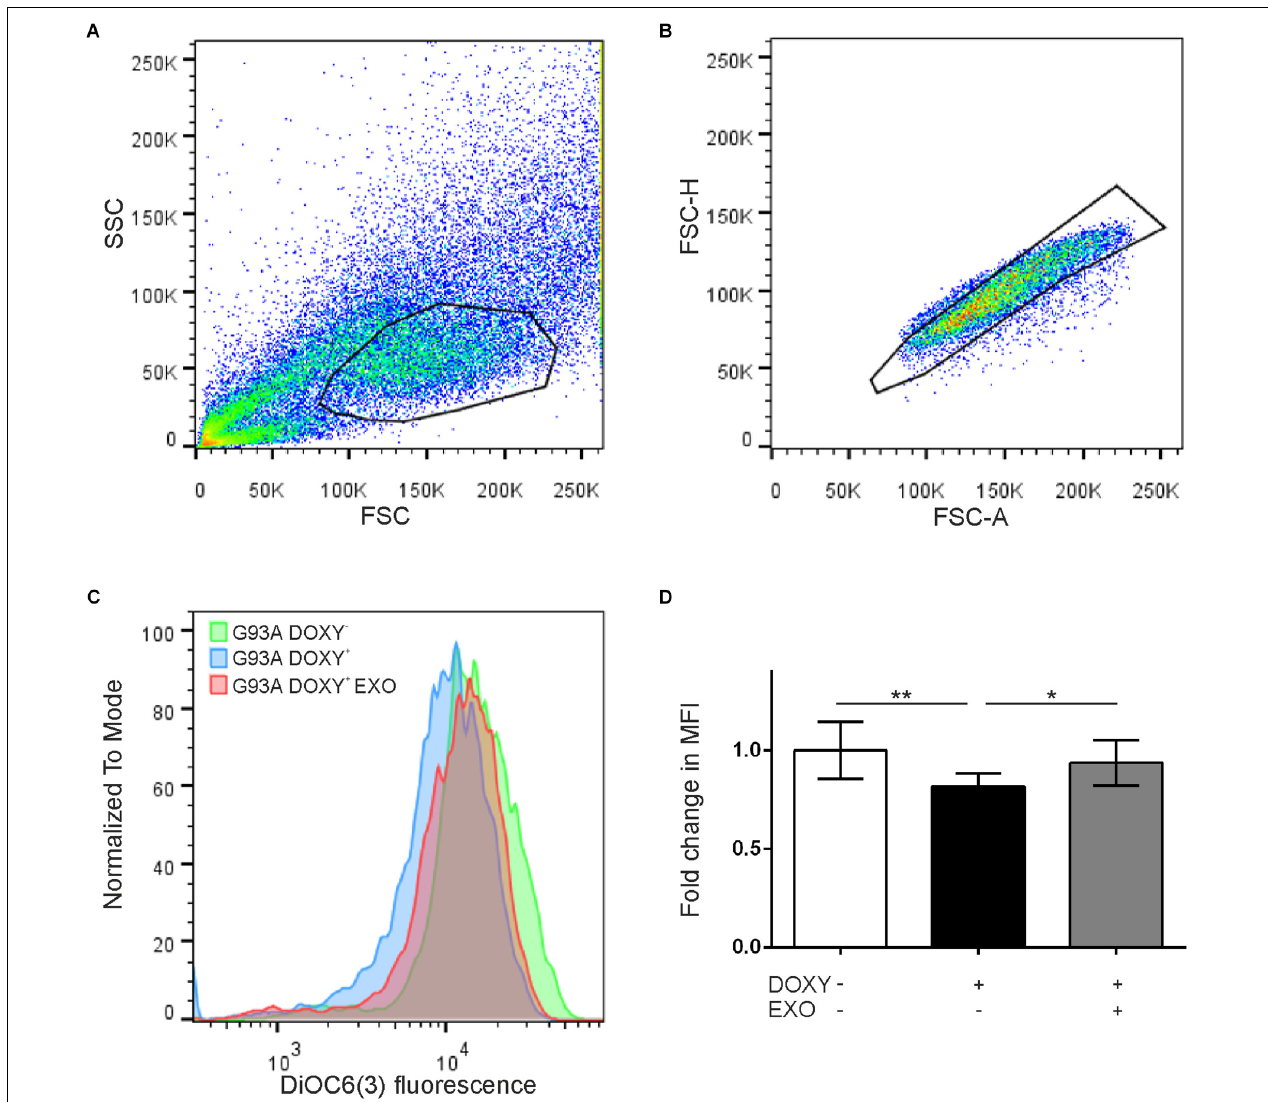
FIGURE 6 | Flow cytometry for mitochondrial membrane potential evaluation in G93ADOXY+ and G93ADOXY– cells. (A,B) Representative dot plots of flow cytometry of all events collected using gates to exclude dead cells and debris (A) and to select the singlets (single cells) (B) . Cell size (forward scatter, FSC) vs. cellular granularity (side scatter, SSC) data are plotted. (C) The histograms show the intensity of DiOC6(3) probe in the G93ADOXY– cells, G93ADOXY+ cells, and G93ADOXY+ cells treated with exosomes (EXO). (D) Measurement of mitochondrial membrane potential with DiOC6(3) probe in cells G93ADOXY– and G93ADOXY+ following treatment with exosomes. Data are reported as median fluorescence intensity (MFI) of the probe relative to the G93ADOXY– cells. The analysis was performed using one-way ANOVA with Tukey correction; p < 0.05. Data are represented as mean ± SD, ∗ p < 0.05, ∗∗ p < 0.01. n =